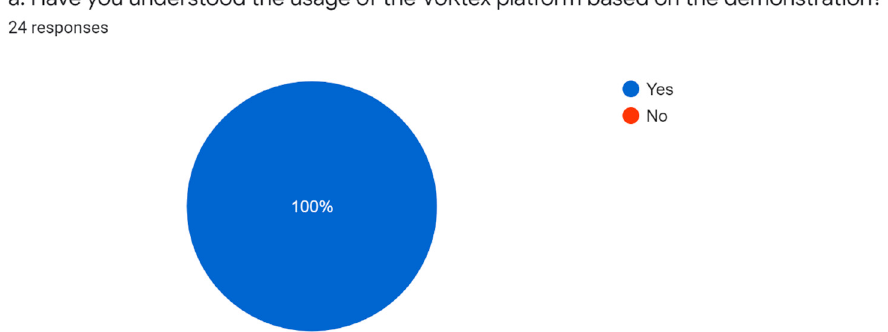
Figure 12. VoRtex test results from Google Forms report. Understanding of the VoRtex platform.